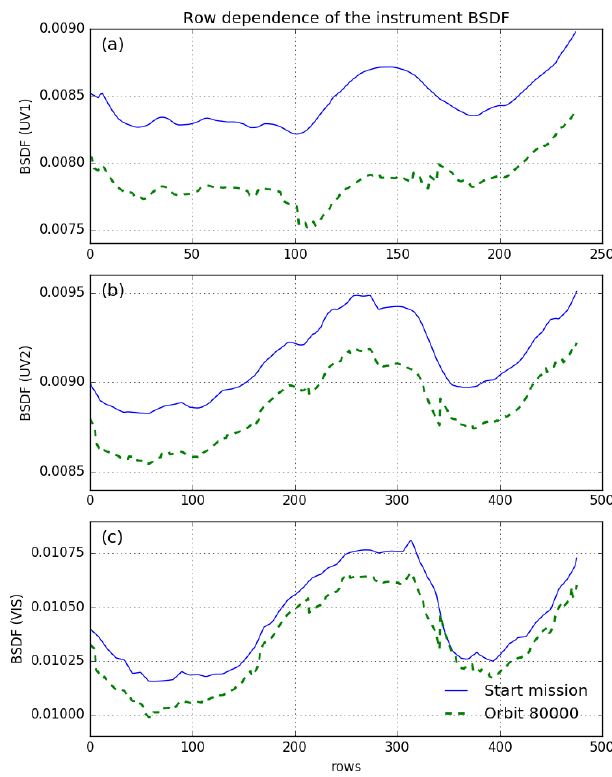
Figure 24. Instrument BSDF using the QVD, showing the row de- pendence of the BSDF for UV1 (band 1, a ), UV2 (band 2, b ), and VIS (band 3, c ). The solid blue lines show the BSDF at the start of the mission and the dashed green lines after 17 years in